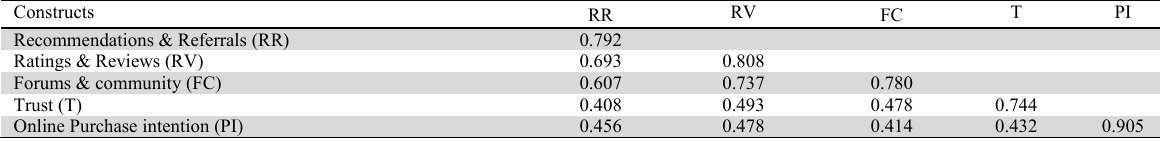
The results of the correlation matrix